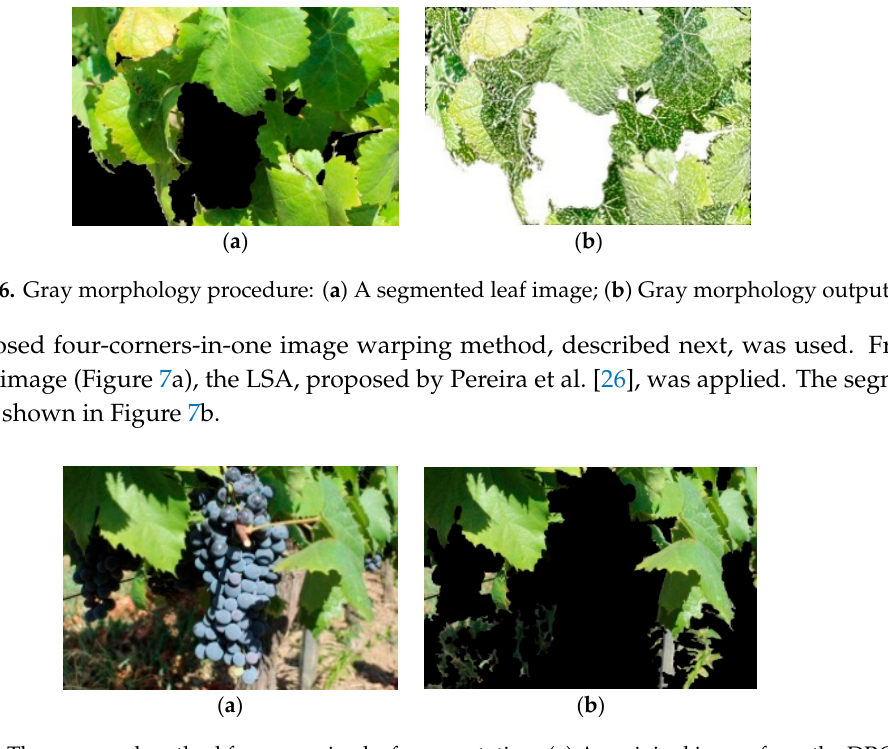
( b ) Figure 4. Independent component analysis: ( a ) DRGV image; ( b ) Convolution output of ( a ) with the first independent components filter (ICF). The next two IPs, the Canny edge detector (CED) proposed by Canny [31] and gray-scale morphology processing (GMP) developed by Zheng and Wang [32], are related with the leaf vein extraction. Leaf venation aims at identifying the vein pattern of a plant species. The primary vein is similar to the main trunk of a tree, while the secondary vein is similar to the major limbs of a tree [13]. In a leaf image, the leaf vein can be seen as noise on the leaf surface and displays distinguishable patterns between species. Methods of noise detection, like mathematical morphology, may be useful for leaf vein extraction. Thus, Zheng and Wang [32] proposed a new method for leaf vein extraction based on GMP, which basically comprised two basic mathematical morphology operations: Erosion and dilation. Other morphology operations, such as the opening and closing operations, the bot-hat transformation, and the top-hat transformation, were produced based on different combinations on these two basic operations. In our case, the complete GMP was composed of six morphology operations, designed according by Equation (1). 𝑔 = (cid:4666)𝑓 ⋅ 𝑏 − 𝑓(cid:4667) − (cid:4666)𝑓 − 𝑓 ∘ 𝑏(cid:4667)